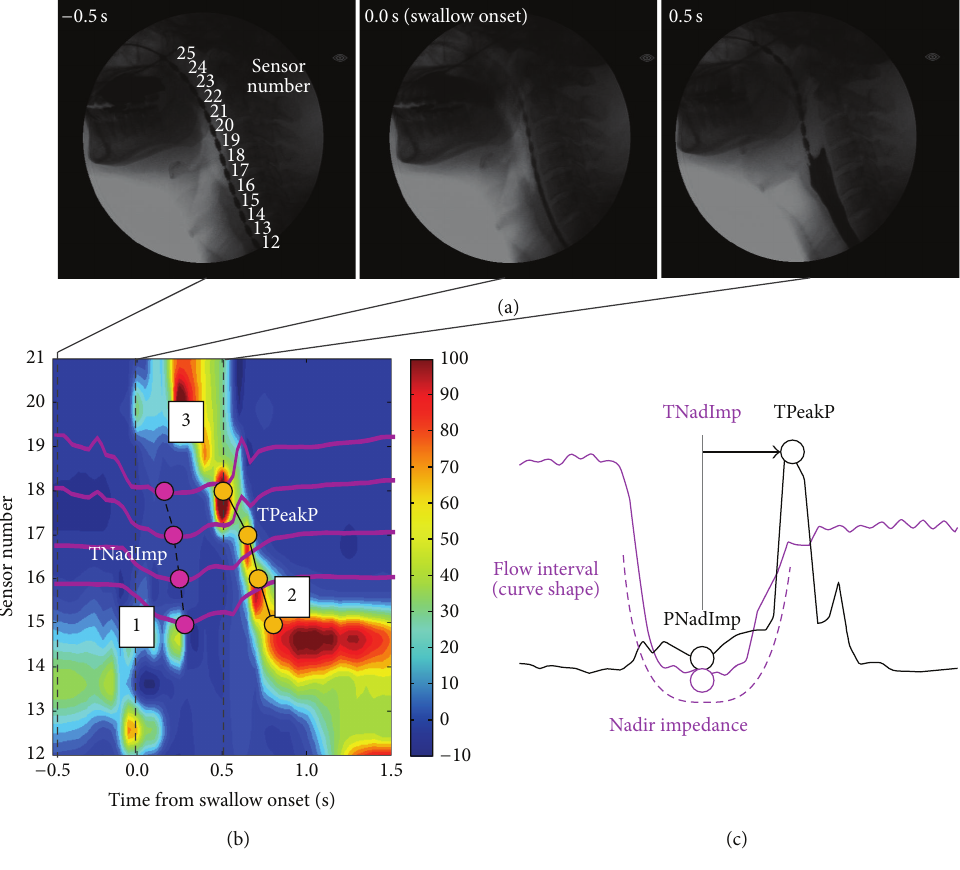
Figure 1: Pharyngeal HRMI and derivation of AIM analysis metrics. (a) Videofluoroscopic images of the catheter in situ in 43-year-old male subject. Consecutive images of a 10-liquid bolus swallow at 0.5 sec before swallow, at swallow onset, and at 0.5 ms after swallow onset. (b) A pressure topography plot of the swallow with impedance waveforms and an example of a PFA metric: PNadImp and PeakP superimposed on the plot. Landmarks defined for AIMplot analysis are marked (1: swallow onset time, 2: position of UES proximal margin post swallow, and 3: position of velopharynx). (c) An illustration showing calculation of the main PFA analysis metrics in the pharynx region. Note: a similar analysis was also applied to the UES region to derive UES Nadir